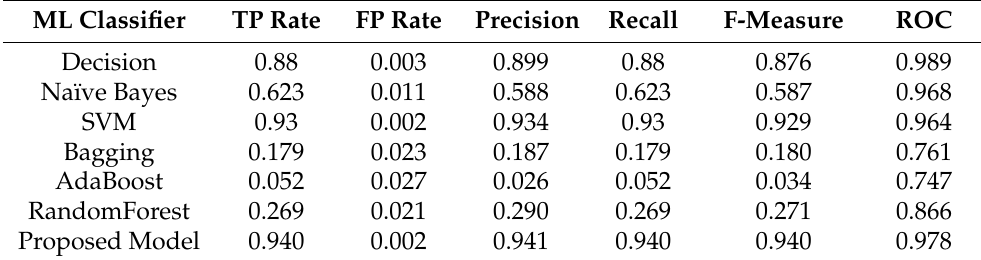
Table 7. Performance analysis of various classifiers over the COVID-19 dataset.